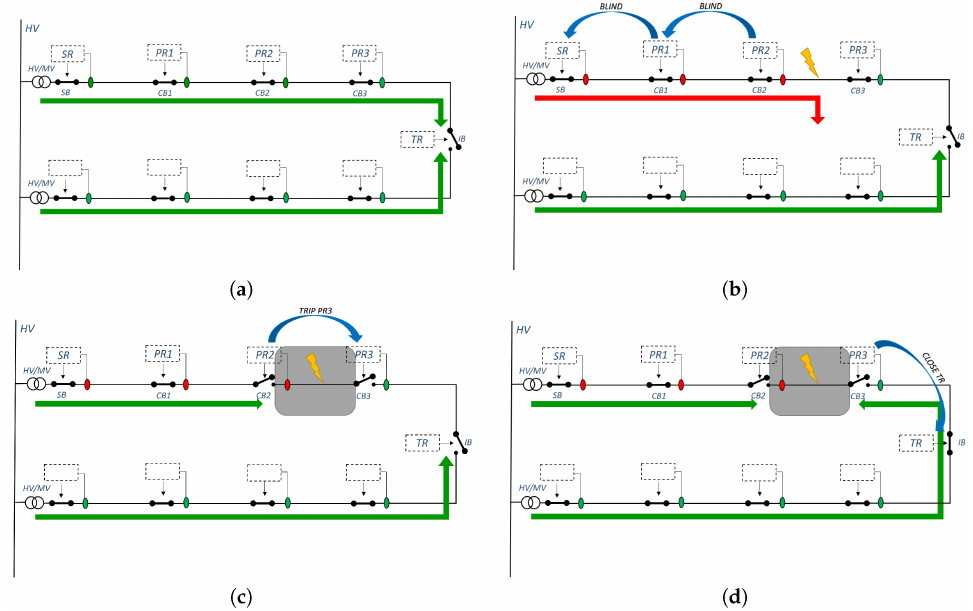
Figure 3. Example of logic selectivity application for faults occurring between ICS2 and ICS3. ( a ) Healthy conditions. ( b ) Fault between protection relay 2 (PR2) and PR3; transmission of blind signals. ( c ) Circuit breaker 2 (CB2) tripping, and transmission of the Trip signal to PR3. ( d ) CB3 tripping and transmission of the Close signal to Tie recloser (TR).